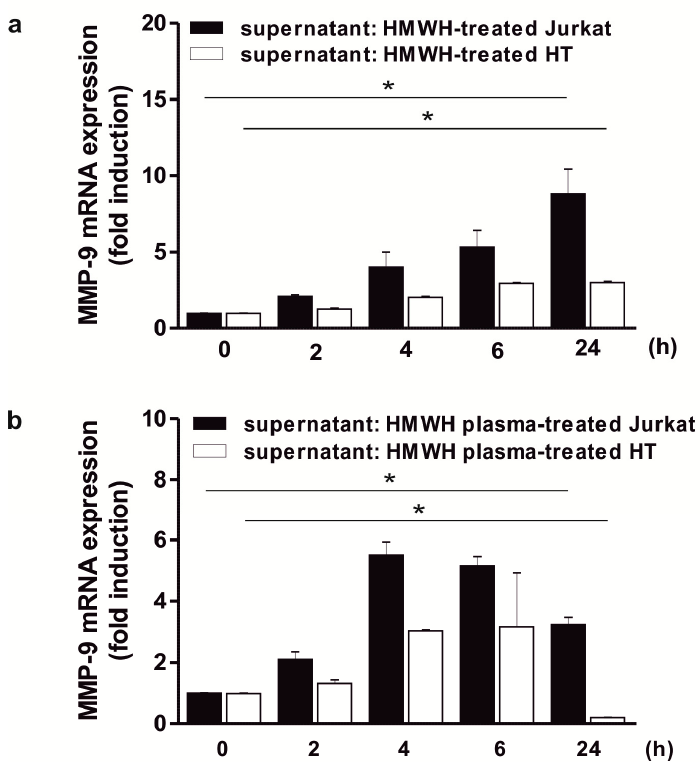
Figure 4. Induction of MMP-9 expression in THP-1 cells by incubation with supernatant from HMWH- and HMWH plasma-stimulated Jurkat cells. 2 × 10 6 THP-1 cells/well were starved overnight and subsequently stimulated up to 24 h with the supernatant of Jurkat or HT cells which have been treated for 24 h with 50 IU/well HMWH ( a ) or HMWH plasma (derived from a heparin monovette) ( b ). MMP-9 mRNA expression was determined using qPCR (QuantiTect Custom Assay; housekeeping gene: GAPDH); mean ± SD, n = 3 (measured in duplicates). Kruskal–Wallis test, * p ≤ 0.05.